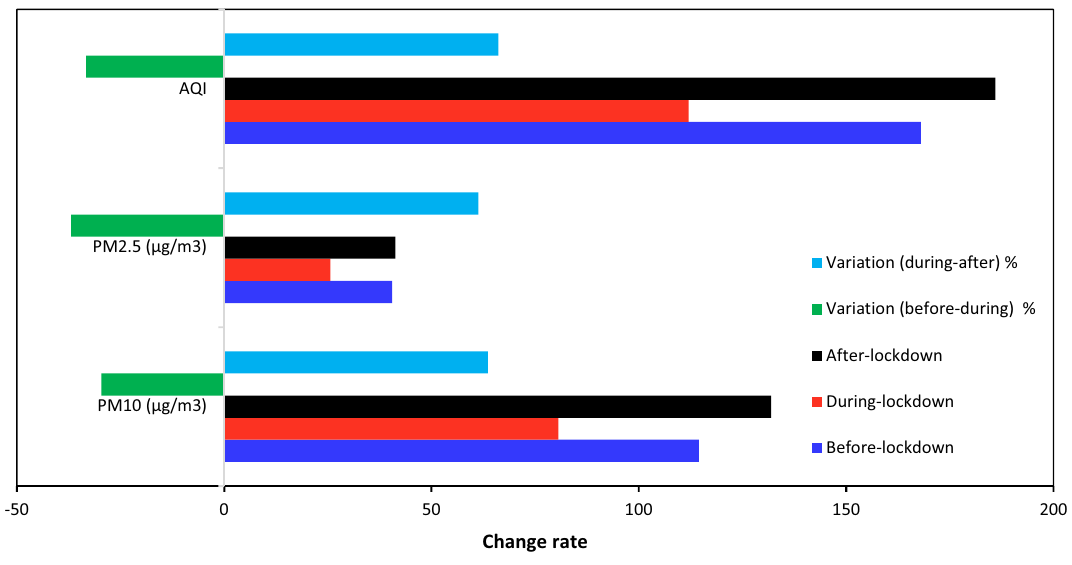
Fig. 6 Mean PM 10 and PM 2.5 concentrations and air quality index (AQI) before (21 February to 21 March 2020), during (22 March to 21 April 2020) and after lockdown (22 April to 21 May 2020) in Ahvaz,